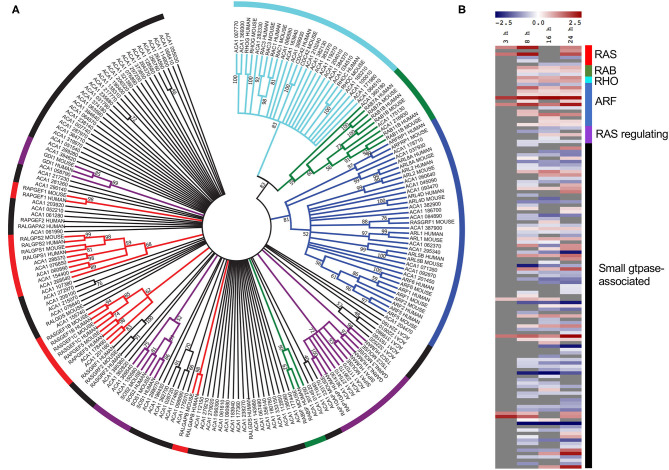
Conservation and differential gene expression of small GTPase-encoding genes in L. pneumophila infected A. castellanii. (A)
A. castellanii proteins (ACA1) allocated the GO-term “small GTPase-mediated signal transduction” were selected for BlastP analysis against Homo sapiens (human) and Mus musculus (mouse), and the top protein hit (p < 0.01) selected. Multiple protein sequence alignment was conducted using ClustalW and the relatedness tree was created using the Maximum Likelihood method in MEGA7 (Kumar et al., 2016). Numbers next to the branching points indicate the relative support from 500 bootstrap replicates (only scores above 40 are shown). (B) Heatmap showing the log2(fold change) in gene expression of wild type L. pneumophila vs. ΔdotA mutant infected A. castellanii genes with GO-term “small-GTPase.” Levels of expression depicted from Blue (−5)—Red (+5), and gray represents insignificant differential expression (PADJ > 0.05).